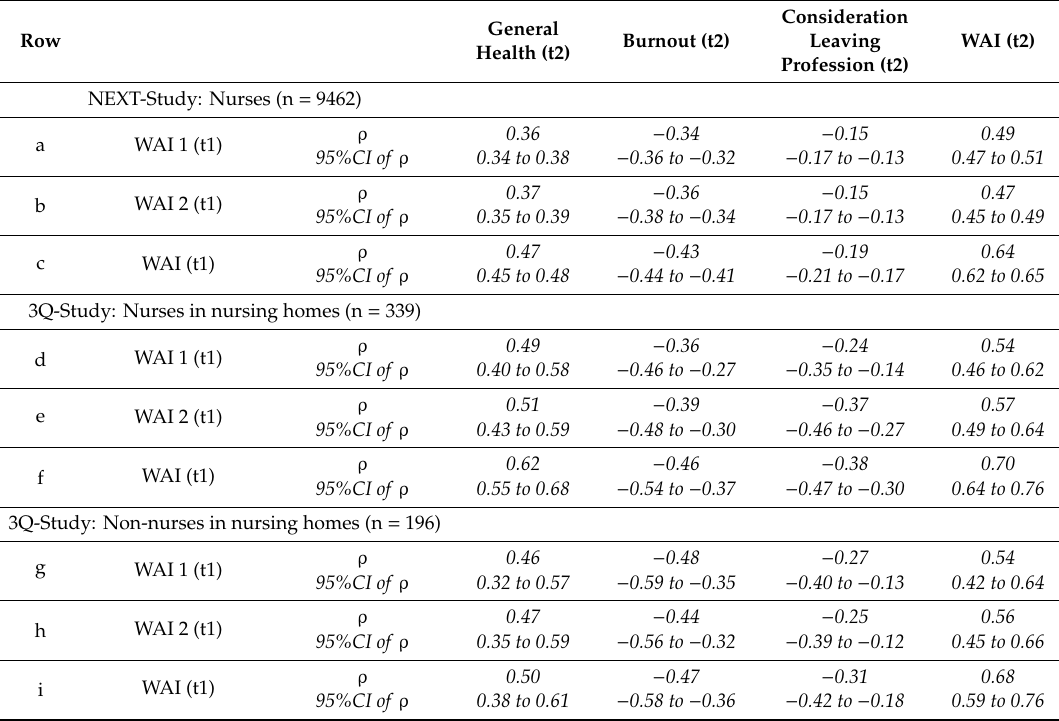
Table 2. Longitudinal analyses—correlation (Spearman’s rho) of WAI 1, WAI 2 and WAI with the outcomes general health, burnout and consideration of leaving nursing. Investigation in three di ff erent longitudinal samples with all outcomes (t2) being assessed 12 months after t1. The 95% confidence intervals of rho were obtained by bootstrapping. All correlations were significant at p <